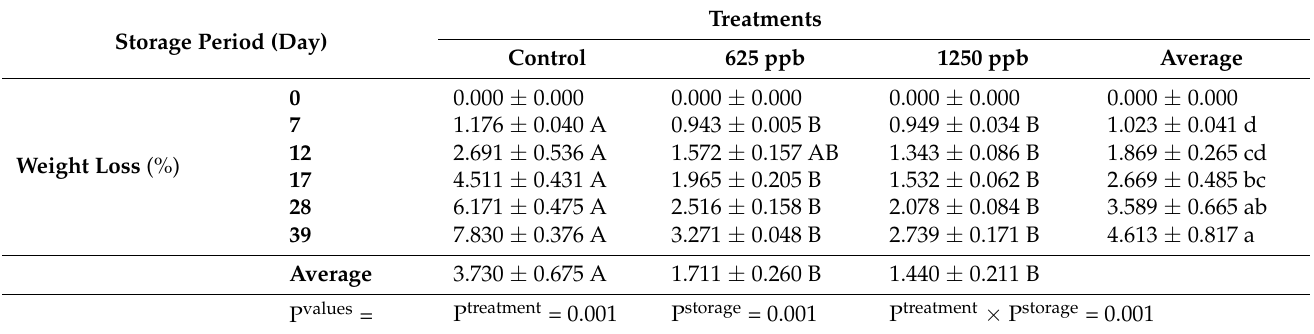
Table 1. The weight loss during storage of ‘Seyit F1’ cocktail tomato ( Solanum lycopersicum L.). Data are presented as means ±